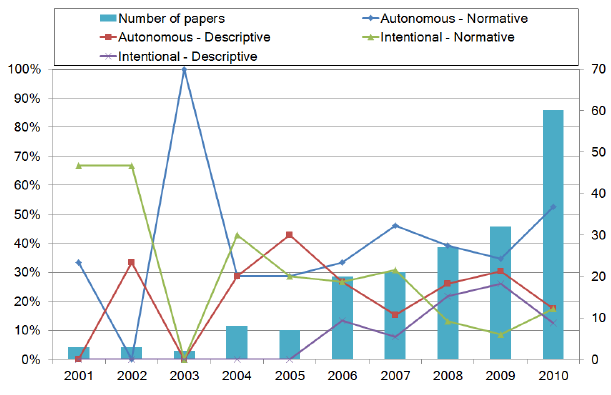
Fig. 3. Share of papers that refer to adaptability according to our four categories (left axis) and total number of papers (right axis). This analysis was based on the first bibliometric search (see